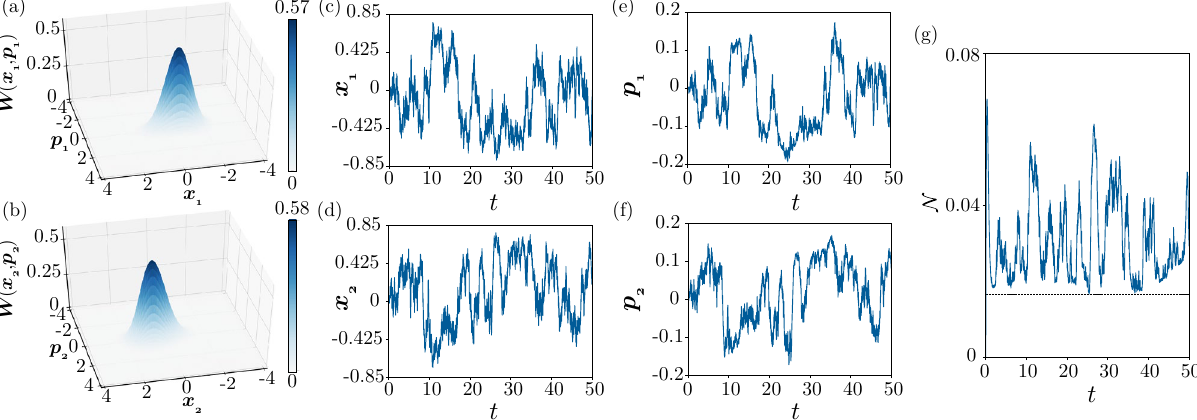
Figure 8. Turing instability under continuous quantum measurement in the weak quantum regime. ( a , b ) 3D snapshot plots of the Wigner distributions W ( x 1 , p 1 ) and W ( x 2 , p 2 ) at t average values of the position and momentum operators for two units: ( c ) ( g ) Time evolution of the negativity N . The parameters are � 1 ( D 0.005 and D 0.995 ), and φ 0.99 , D D h c = x = p = = − line represents the value for the steady state of the system without performing measurement.